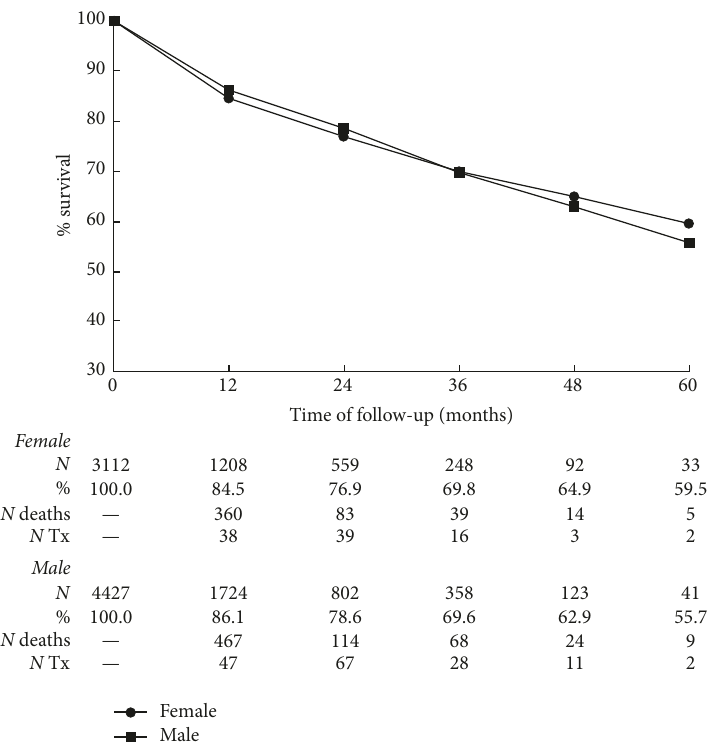
Figure 1: Survival curves for incident dialysis patients by gender. The number of patients at risk in the beginning of each time interval and the percent survival are given at the bottom of the graph as well as the number of deaths and kidney transplants after each period by gender. 𝑃 = 0.571 for the comparison between the curves.